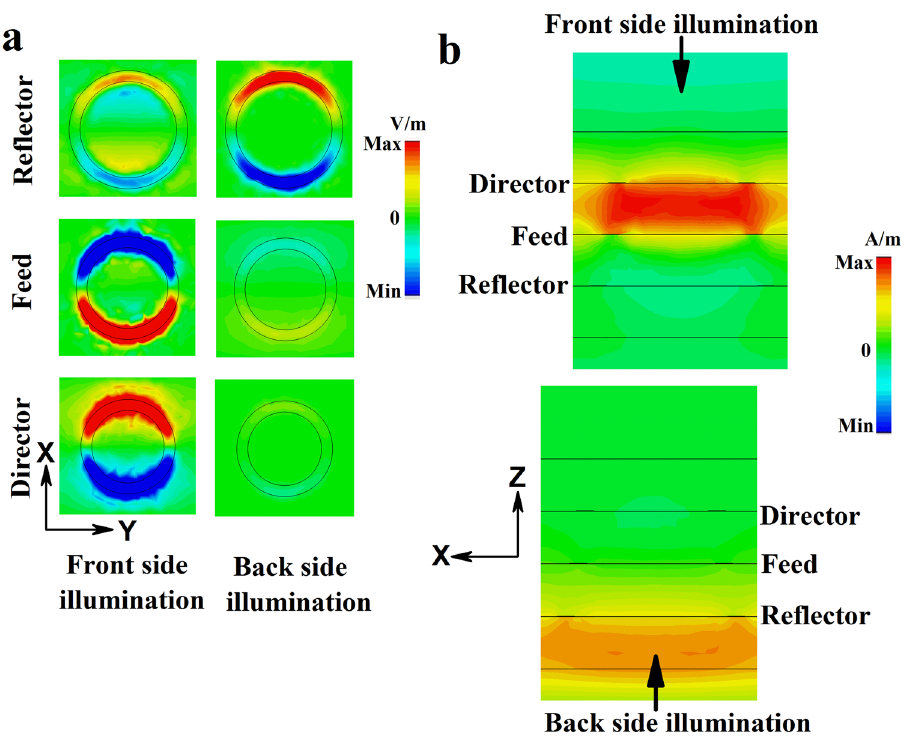
Figure 9. ( a ) Z-component of the electric field at bottom surfaces of three rings; Reflector (bottom), feed (middle) and director (top). ( b ) Y-component of magnetic field inside dielectric spacer layers for both front and back side illumination at 0.657